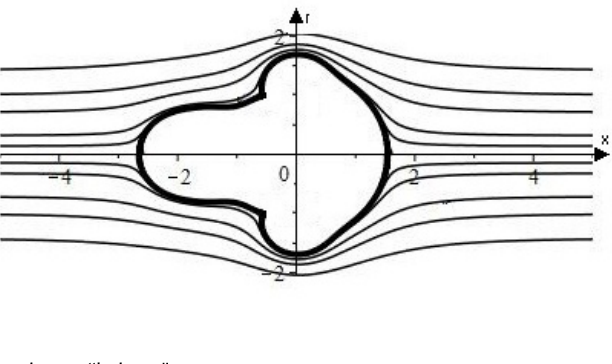
Figure 6: The streamline along a